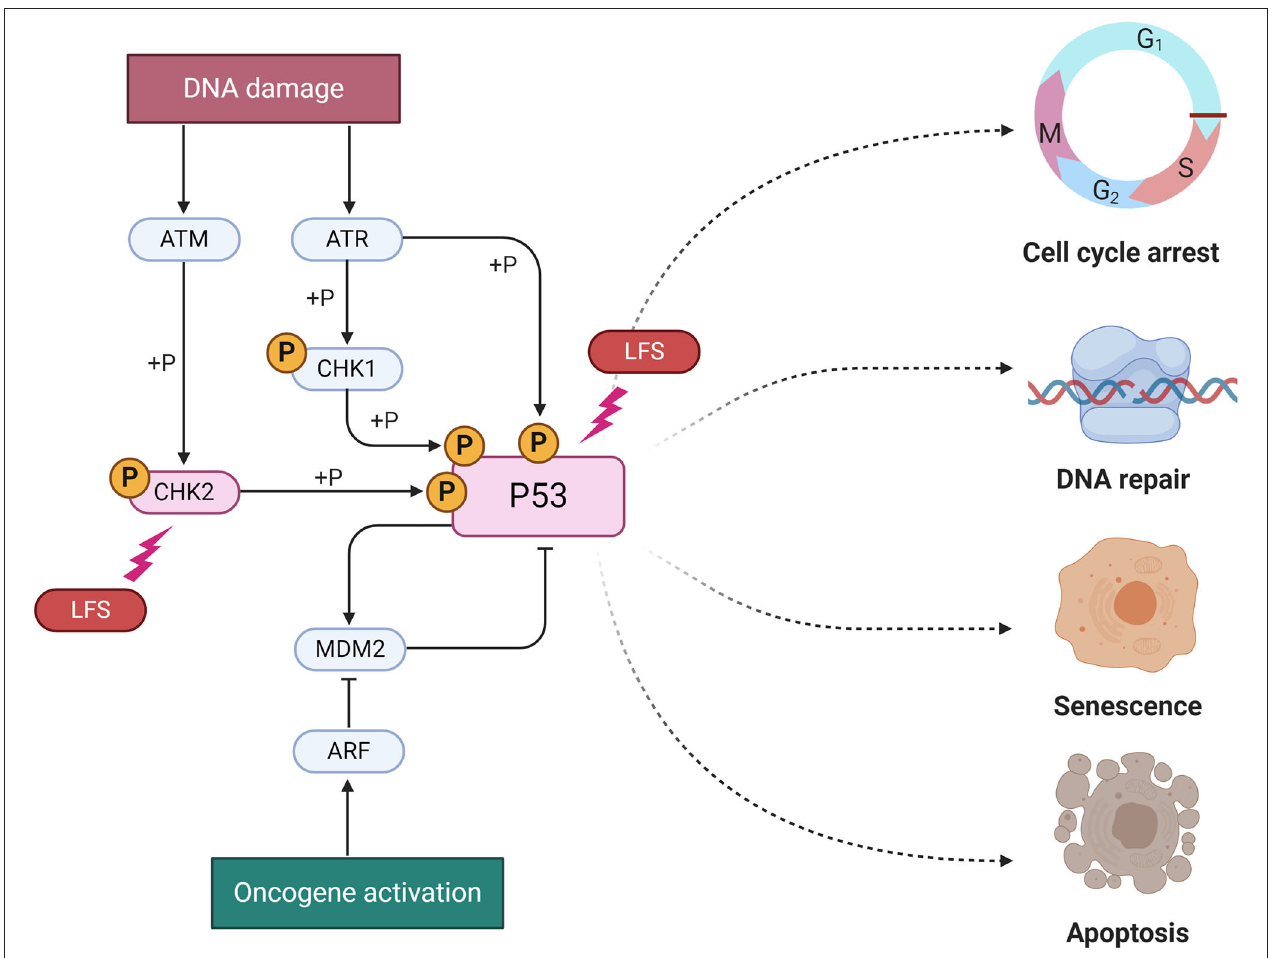
FIGURE 1 | Molecular pathways of Li-Fraumeni (LFS) Syndrome. The two known mutation for LFS are represented here ( P53 and CHK2 ) as lighting bolt. A group of protein kinases such as ATM, ATR, CHK1, CHK2 is implicated in the genome integrity checkpoint, a molecular cascade that detects and responds to several forms of DNA damage caused by genotoxic stress. Oncogenes also stimulate p53 activation, mediated by the protein ARF. In a normal cell, p53 is inactivated by its negative regulator, MDM2 . Upon oncogene activation, various pathways will lead to the dissociation of the P53 and MDM2 complex. Once activated, p53 will induce a cell cycle arrest to allow either repair and survival of the cell or apoptosis to discard the damaged cell. Adapted from “P53 Regulation and Signaling,” by BioRender.com (2020). Available online at: